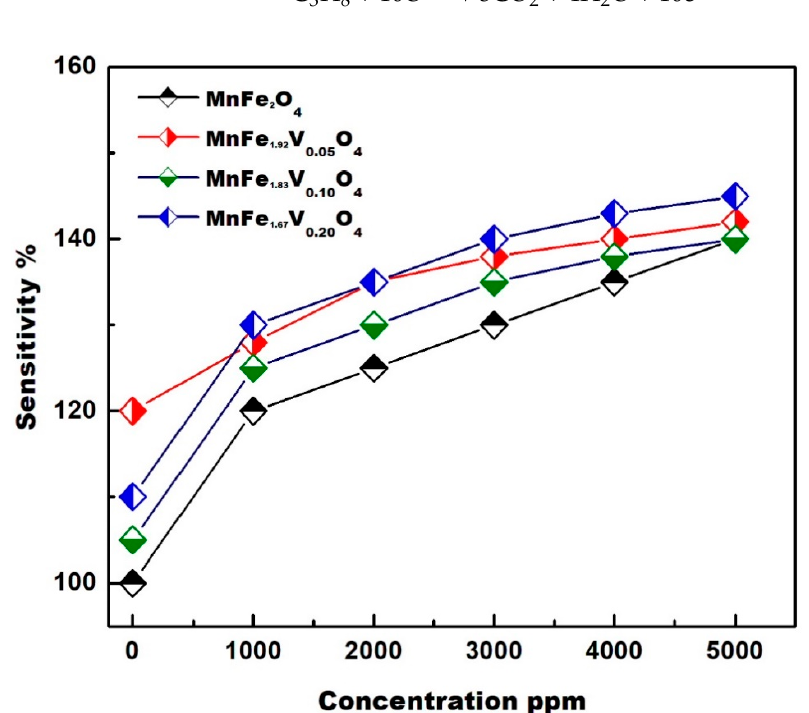
Figure 10 . Variation in sensor response with different LPG concentrations at 200 °C; MnFe 1–1.67x V x O 4 Figure 10. Variation in sensor response with different LPG concentrations at 200 ◦ C; MnFe 1–1.67x V x O 4 (x = 0.05, 0.1, and 0.2). (x = 0.05, 0.1, and